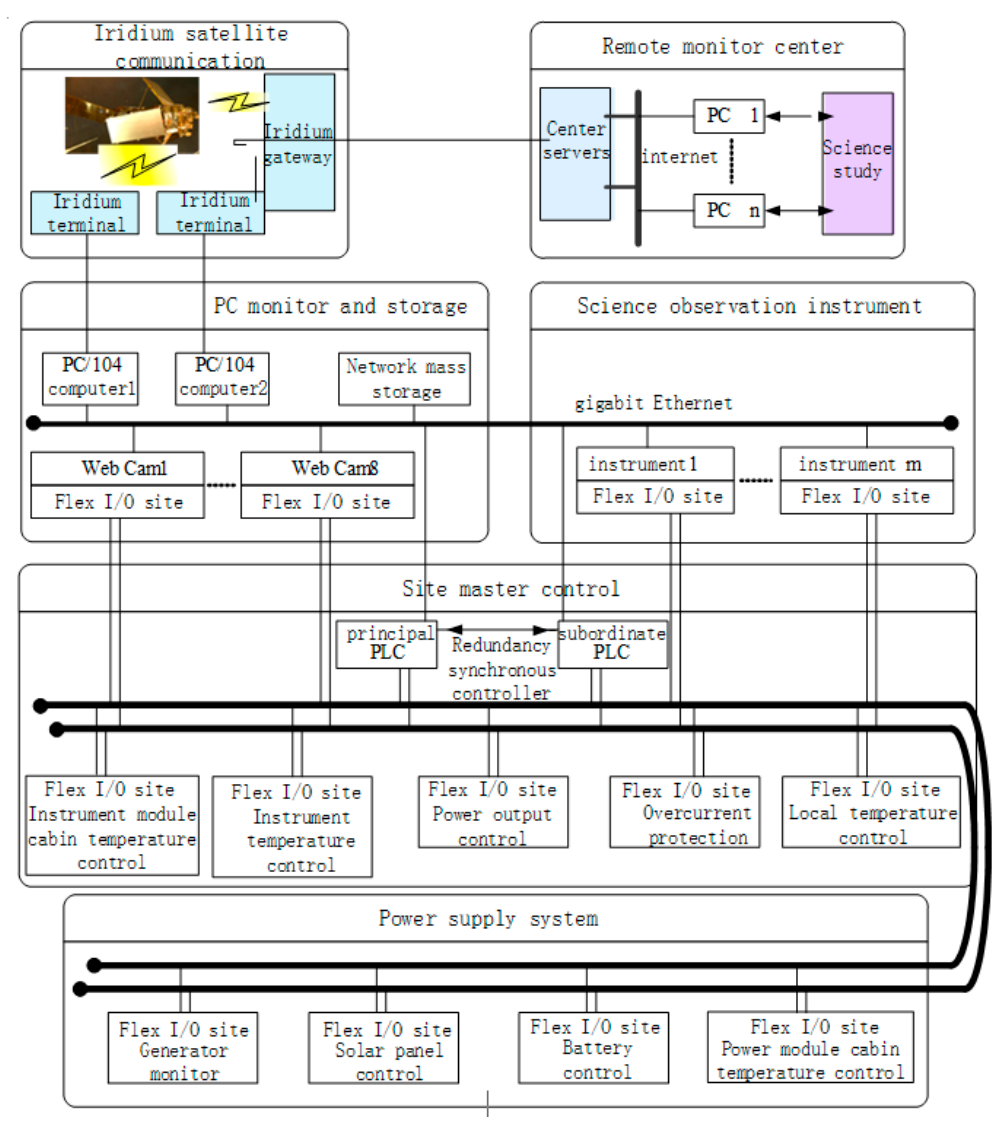
Figure 1. Subsystems and the mutual relationship between them.